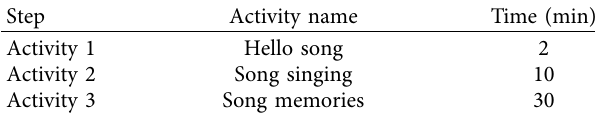
Table 2: Schedule of music therapy activities.